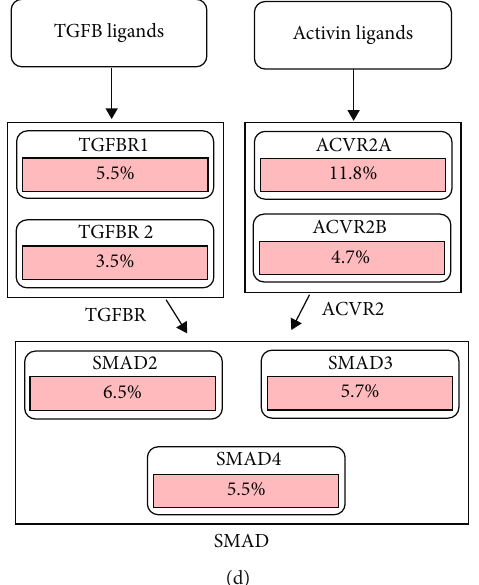
Figure 7: Mutation feature of BCHE in EC from TCGA cohort using the cBioPortal tool. (a) The alteration frequency with mutation type of BCHE in EC from TCGA cohorts. (b) K-M survival analysis of OS with or without BCHE alteration. (c) Mutation sites of BCHE in EC. (d) The relationship between the TGF- β signaling pathway and BCHE